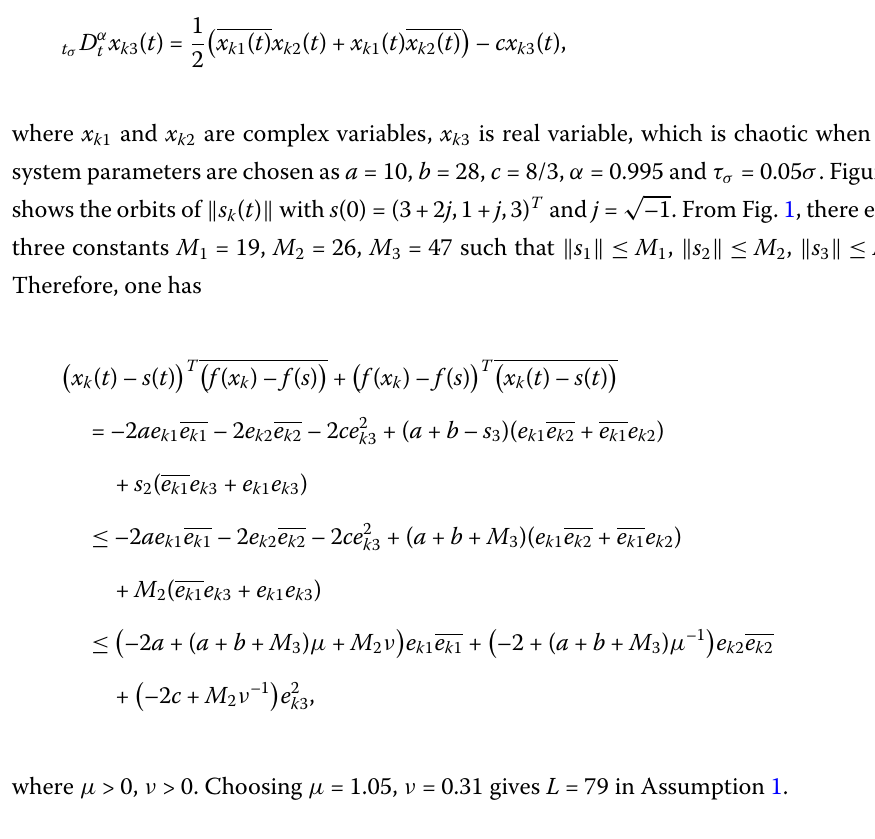
√ –1. From Fig. 1, there exist